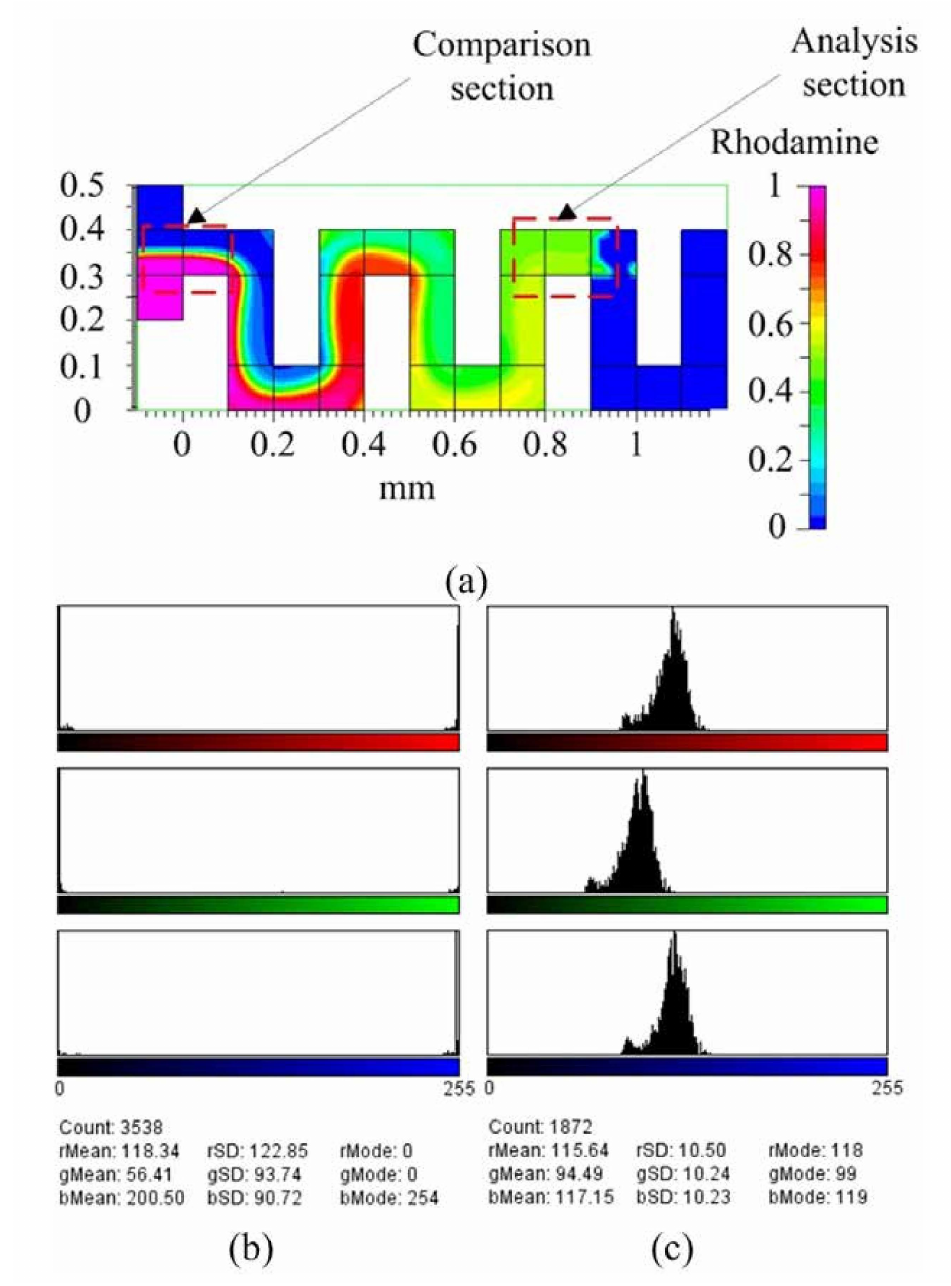
Figure 15. The CFD-ACE simulated mixing extent of the meander micromixer at: ( a ) Comparison po- sition and analysis position, ( b ) RGB concentration at comparison position, and ( c ) RGB concentration at analysis